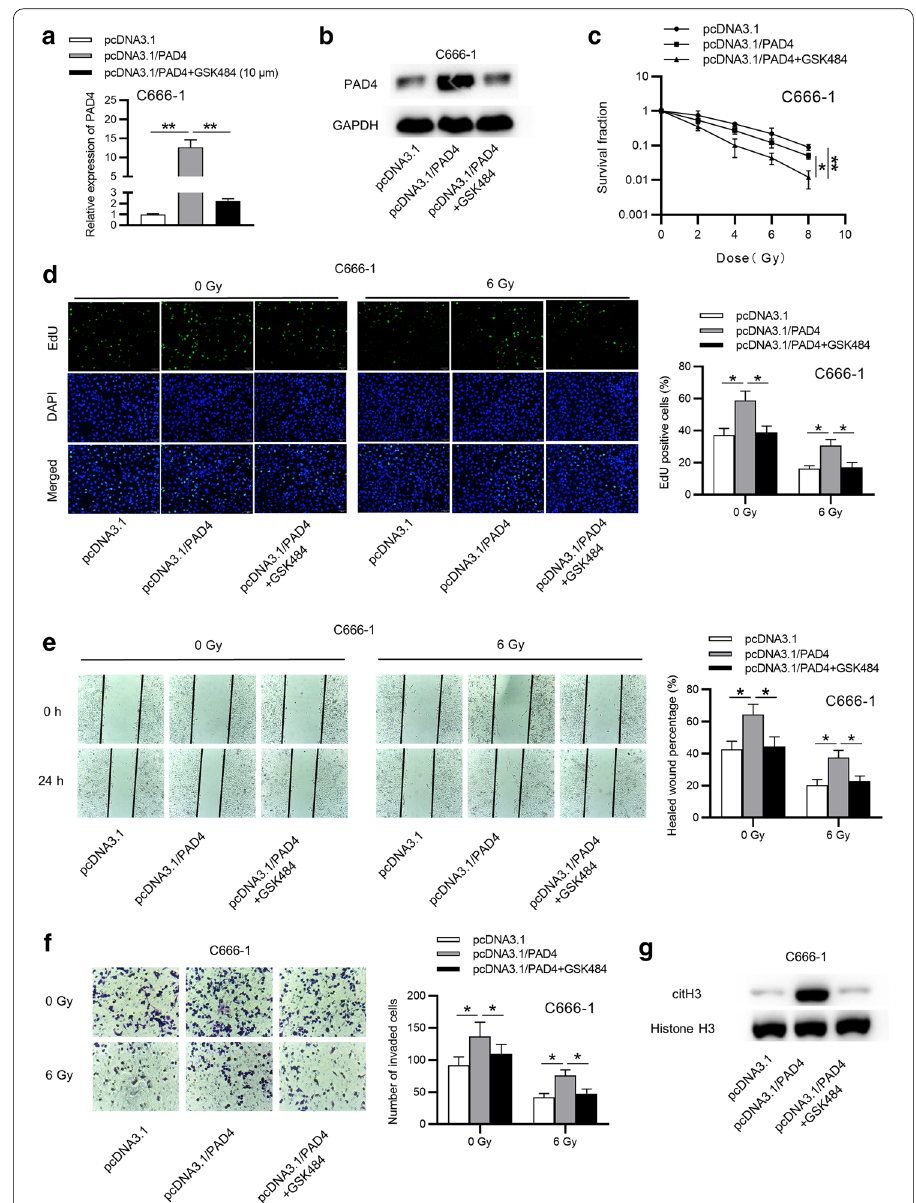
Fig. 4 Treatment of GSK484 attenuates the effect of PAD4 overexpression of NPC cell functions. a , b The PAD4 level in NPC cells treated differently by RT-qPCR and western blot analyses. c Colony formation assay for the survival of NPC cells treated differently. d Cell proliferation in NPC cells treated differently by EdU assay. e , f Migration and invasion ability in NPC cells treated differently by wound healing and Transwell. g The citH3 protein levels in NPC cell treated differently by western lot. One-way ANOVA with Tukey’s post hoc test. *p < 0.05, **p <